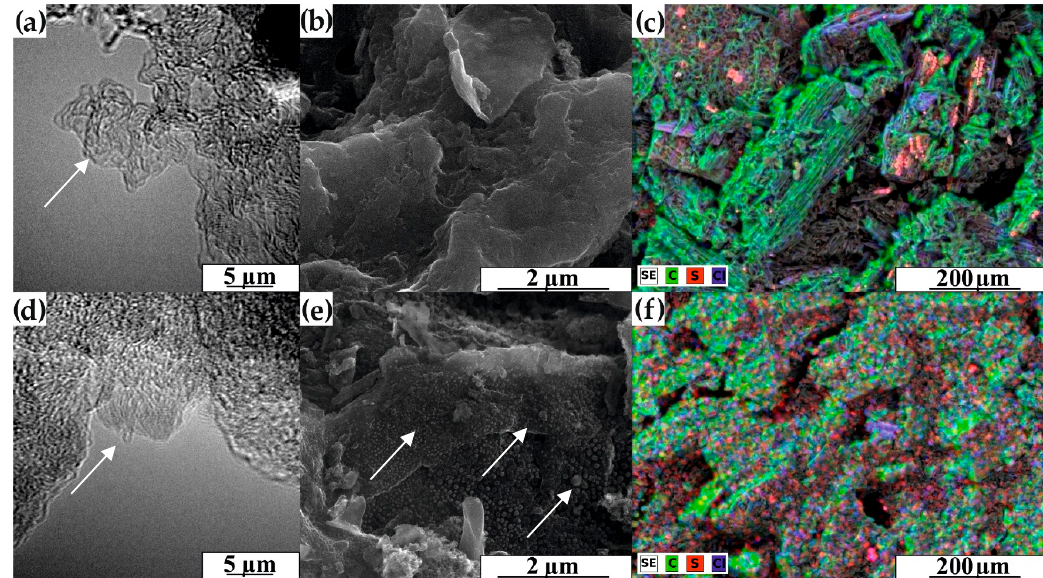
Figure 3. Morphology of the samples: ( a ) HRTEM of Norit_2_raw, ( b ) SEM of Norit_2_raw, ( c ) SEM/EDX mapping of Norit_2_3T, ( d ) HRTEM of Norit_2_3T sample, ( e ) SEM of Norit_2_3T sample and ( f )